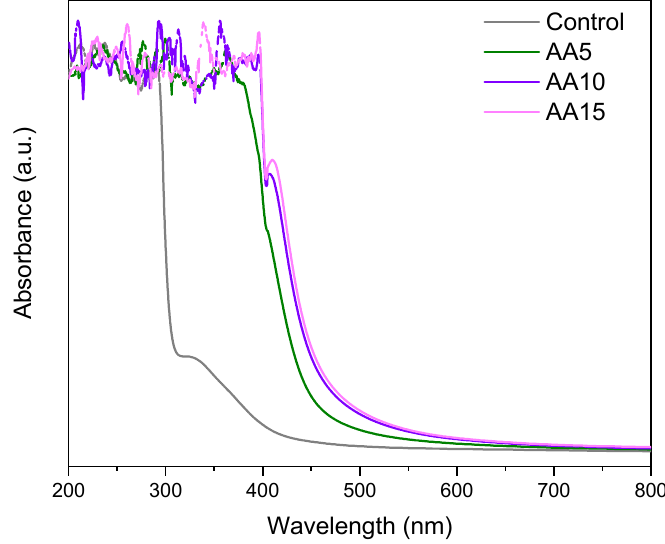
Figure 5. UV-Vis spectra of WPI films as a function of ascorbic acid (AA) content. WCA is a good indicator of the film tendency to absorb water; thus, this